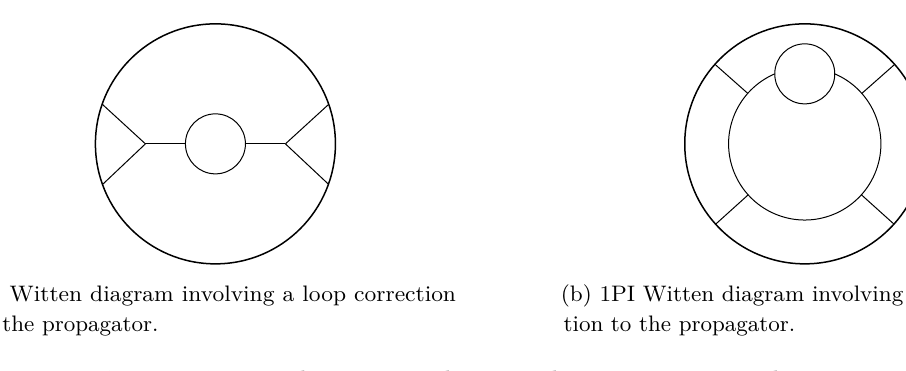
Figure 2 . Witten diagrams involving one-loop corrections to the